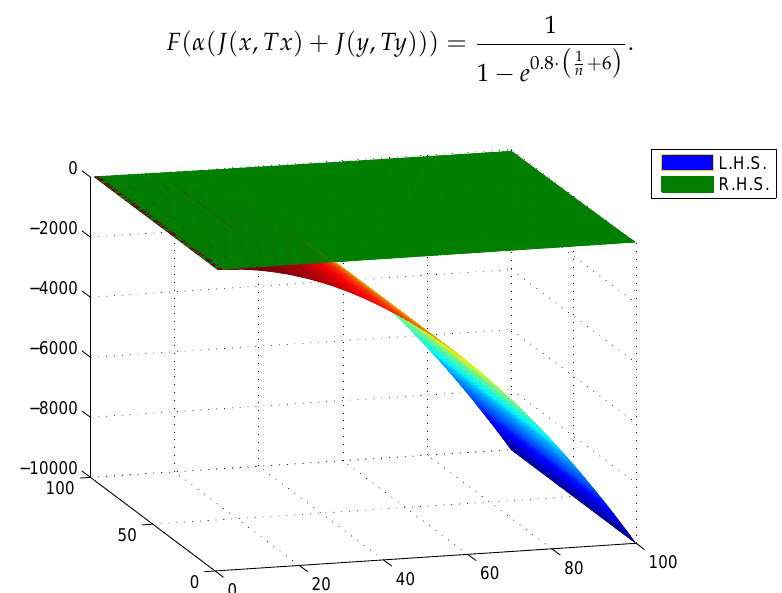
Figure 3. The value of the comparison of L.H.S. and R.H.S. of Equation (20) in the 3D view.